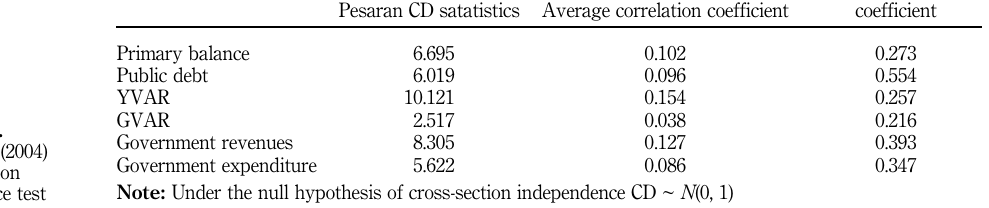
cross-section dependence